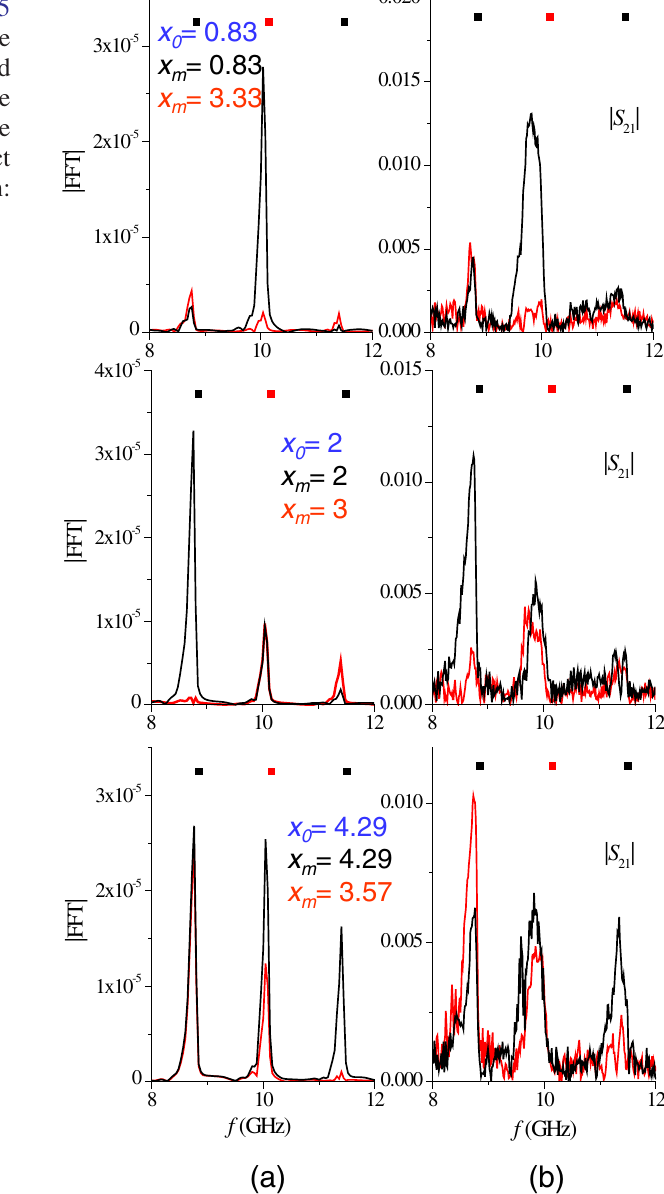
FIG. 6. Same as Fig. 5, except for different emission and measurement points, and a higher frequency